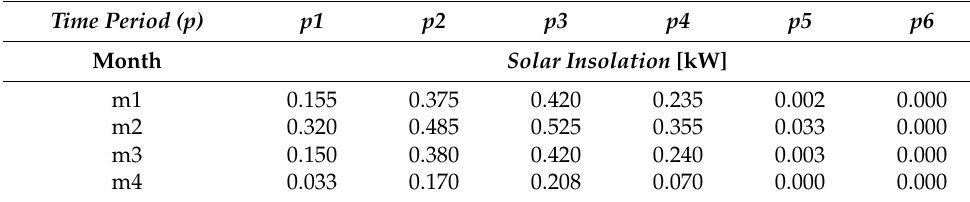
Table 2. UK solar insolation data (adapted from [16]).